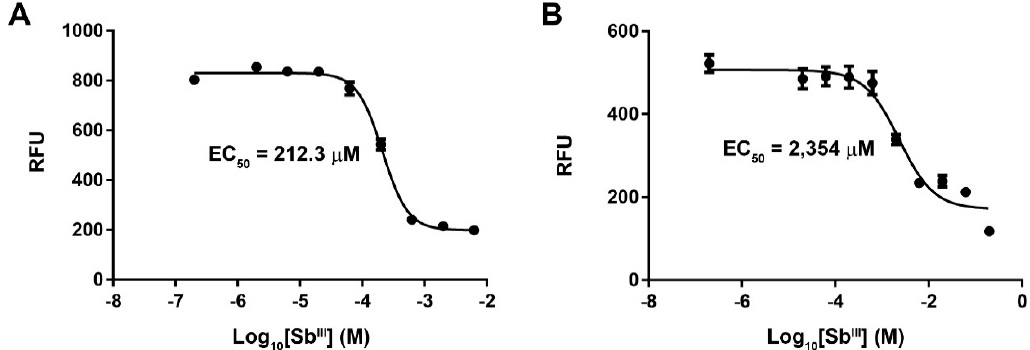
Figure 1. Variation of the EC 50 value in a laboratory strain of L. panamensis exposed to increasing concentrations of antimony tartrate. Figure shows the dose–response curves for the untreated PSC-1 strain ( A ) and the final-stage parasite culture exposed to 2000 µM of Sb III ( B ). Response is shown as relative fluorescence units (RFU) measured as part of the resazurin assay.